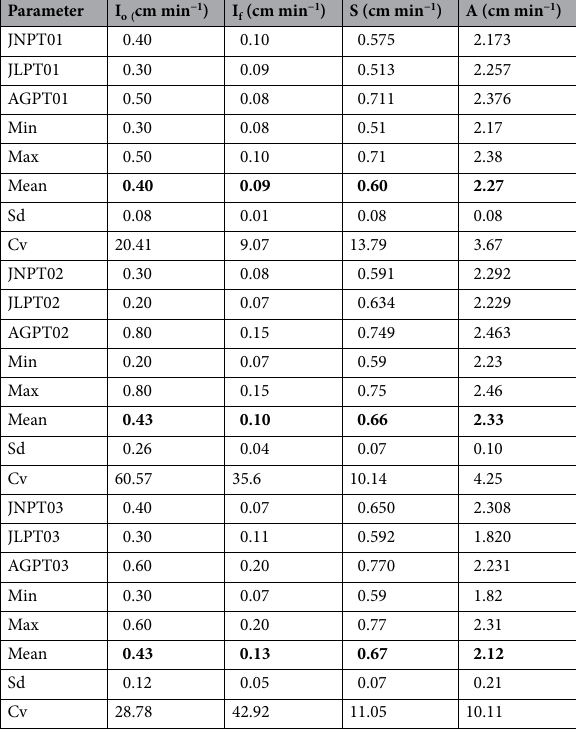
Table 1. Infiltration characteristics of the dumpsite soil. JNPT01 = Point 1 in June; JLPT01 = Point 1 in July; AGPT01 = Point 1 in August, JNPT02 = Point 2 in June; JLPT02 = Point 2 in July; AGPT02 = Point 2 in